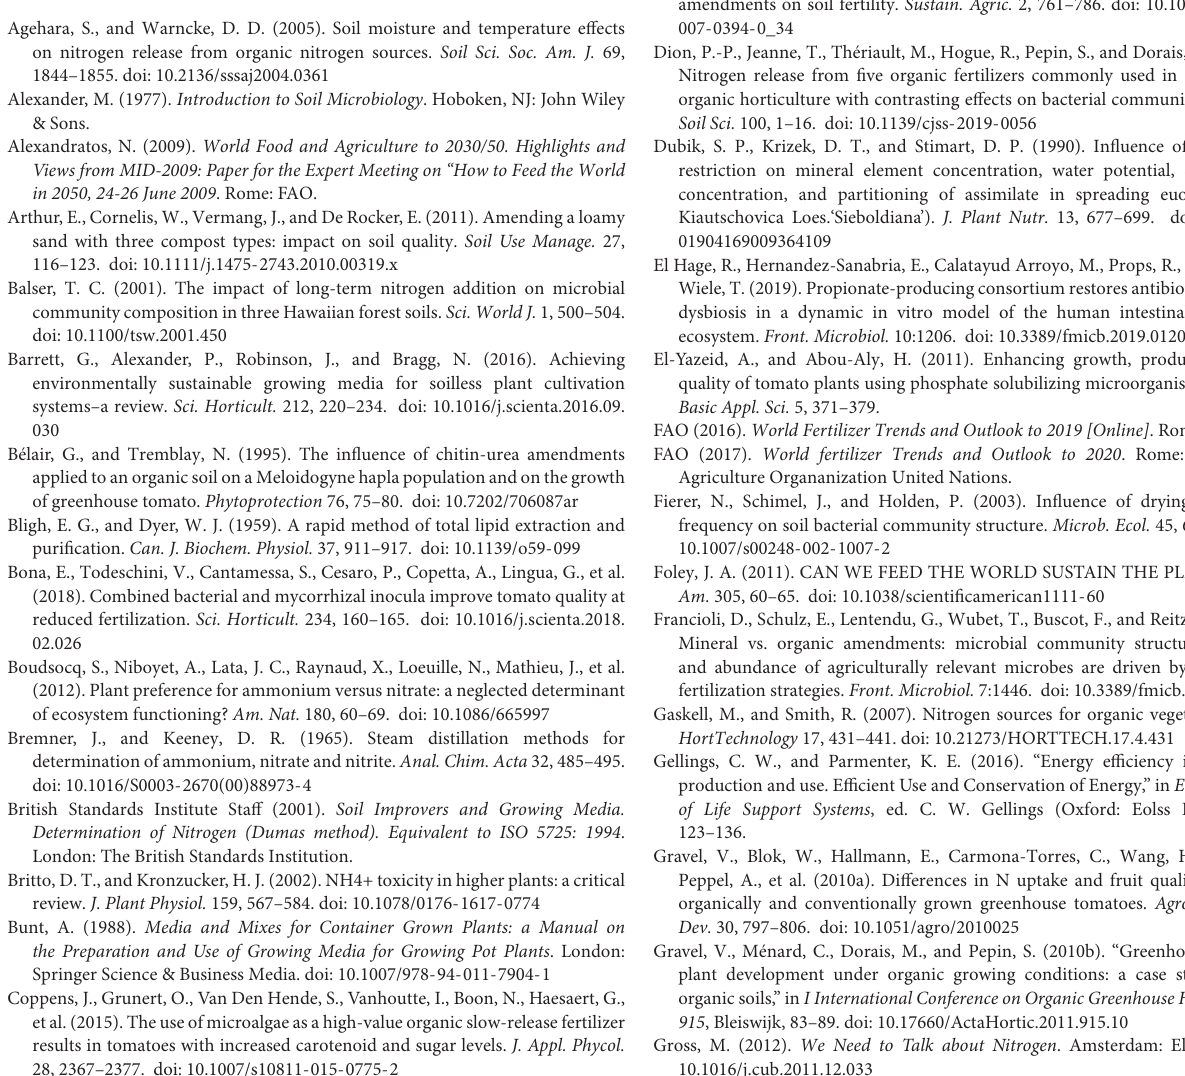
Supplementary Table 2 | Overview of the chemical composition of the different fertilizers used. “ − “ means that the elements was not analyzed or specified. “ ∗ ” means according to the specifications of the supplier. “ ∗∗ ” means that the chemical composition was actually analyzed. Supplementary Table 3 | Overview of the fertilizers used and the total amount used for the different treatments. GBOF, soilless culture system with organic growing medium and organic fertilizer. GBFISH, soilless culture system with organic growing medium and fish. SOILANIMAL, organic soil with animal-derived material as fertilizer; and SOILPLANT, organic soil with plant-derived material as fertilizer. Supplementary Table 4 | Overview of the chemical composition of the four different organic fertilizers (Nutrikali, ANTYS MgS, Biosyr and SP). “–“: means that this element was not determined in the fertilizer.